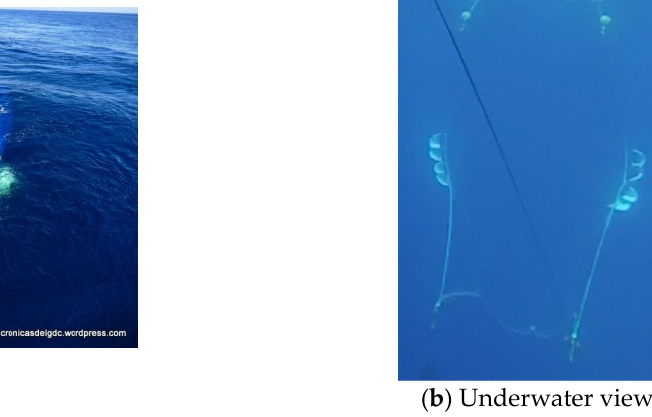
Figure 1. Surface ( a ) and underwater ( b ) images (Félix Descalzo) of the mouth of Mesopelagos net. Observe the kites in the wings and floats in the headrope.